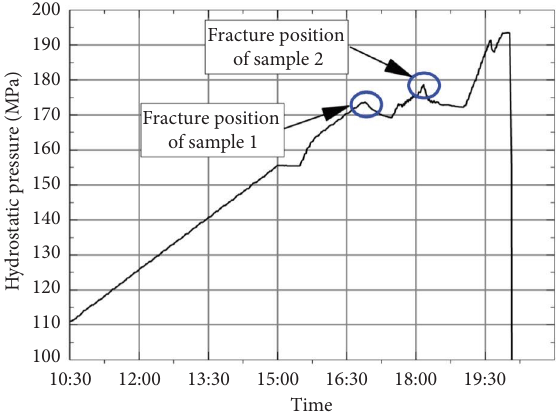
Figure 6: Ultimate strength test curve of T -68.